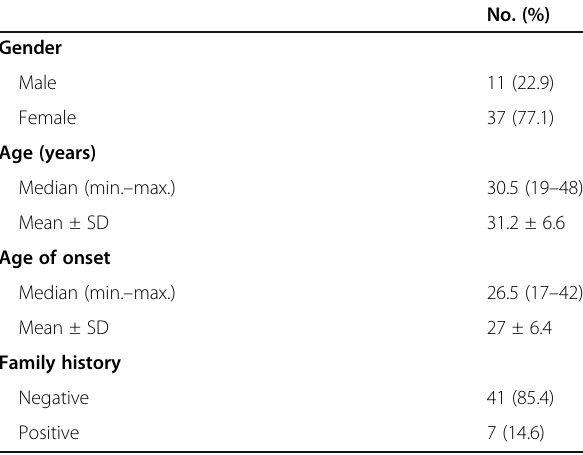
Table 1 Distribution of the studied cases according to demographic data at initial visit ( n = 48)